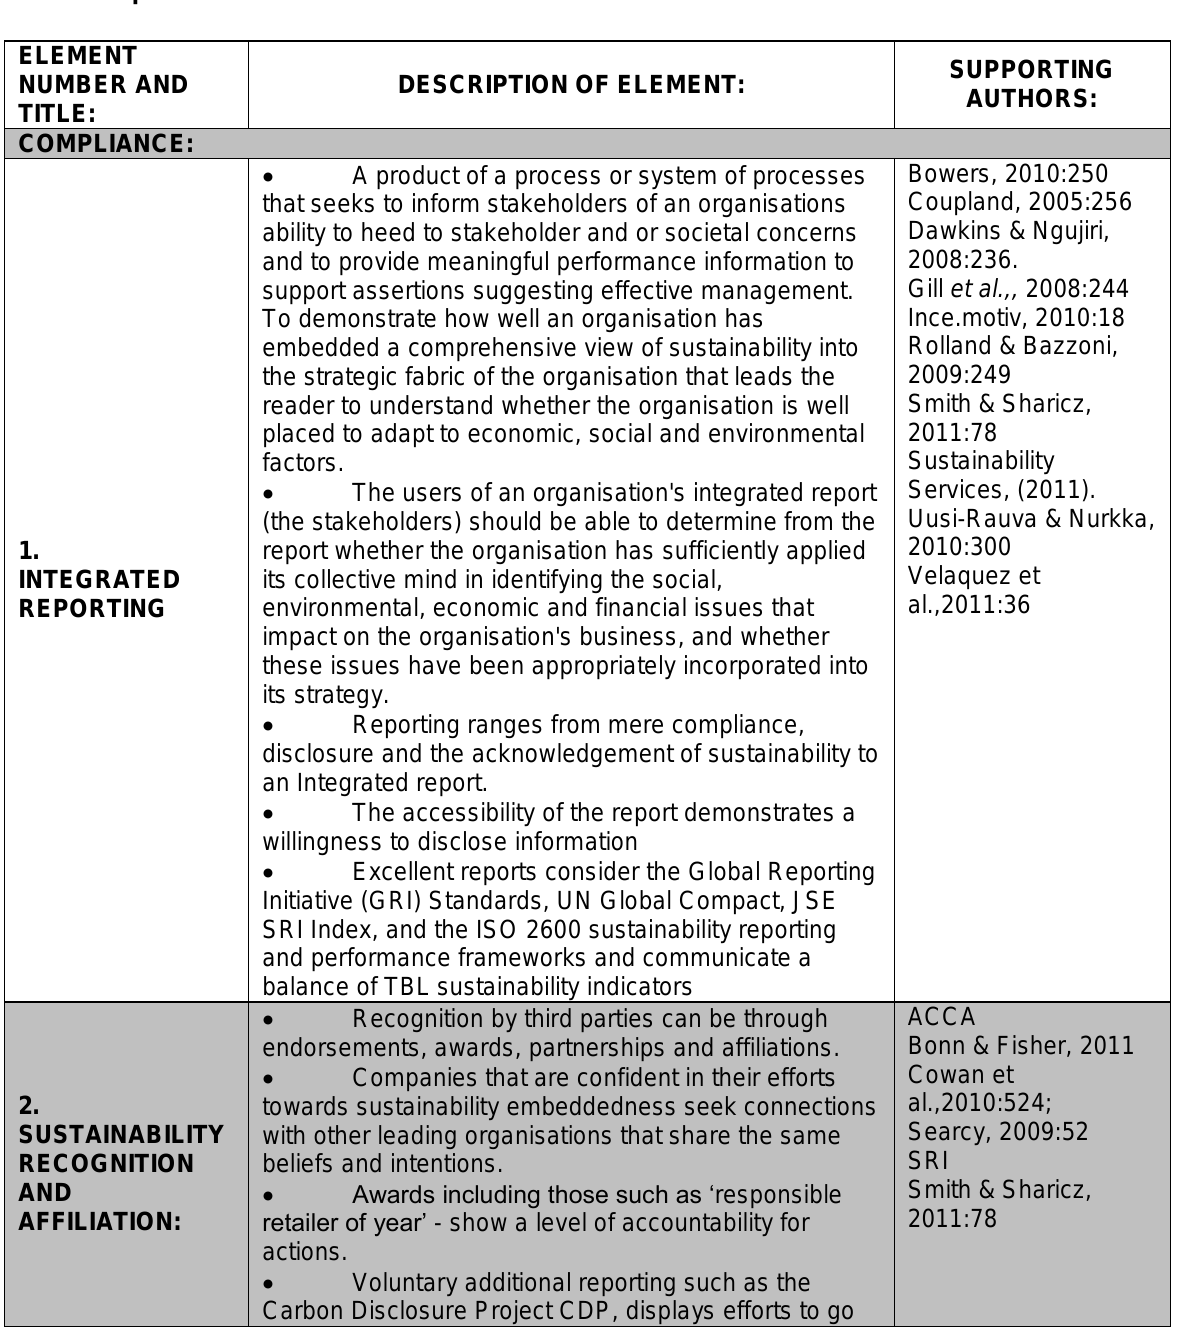
Table 2: Elements of the SSI tool as derived from a content analysis of literature on